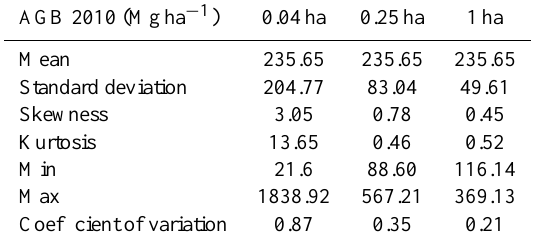
Table 3. 2010 AGB statistics, from field estimations. AGB is highly variable and its distribution is skewed toward low values when using 0.04ha subplots, but becomes more stable at 0.25ha and